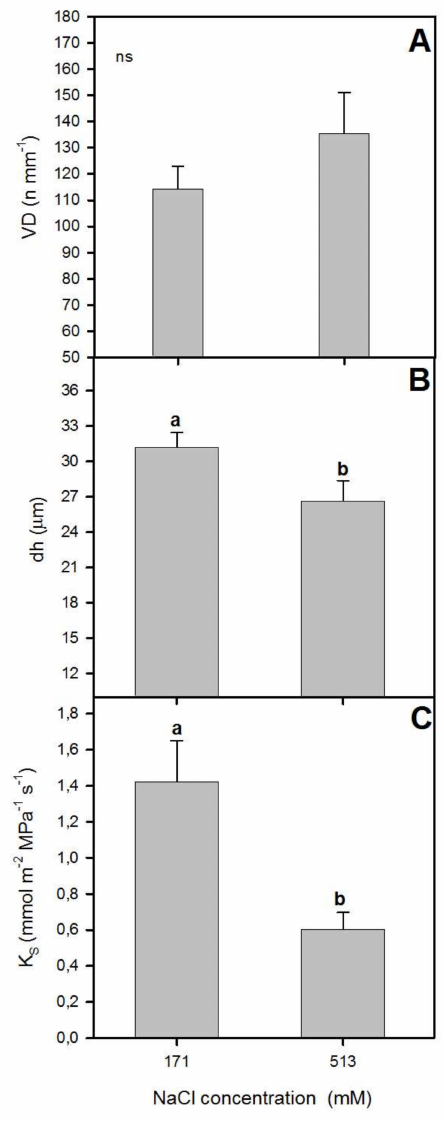
Figure 2. Xylem specific theoretical conductivity, K S ( A ), vessel density, VD ( B ), and hydraulic mean diameter, dh ( C ) in randomly selected primary leaves of Atriplex halimus L. in response to treatment with two NaCl concentrations (171 and 513 mM) after 60 d of treatment. Values represent mean ± SE, n = 3. Di ff erent letters indicate means that are significantly di ff erent from each other (ANOVA test, p < 0.05) and ns indicates non-significant di ff